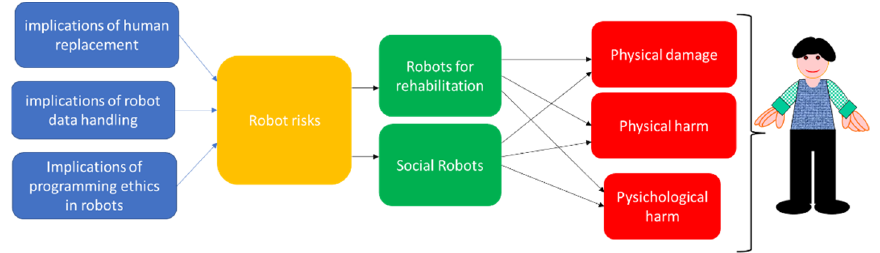
Figure 5. Model of impact of ethical